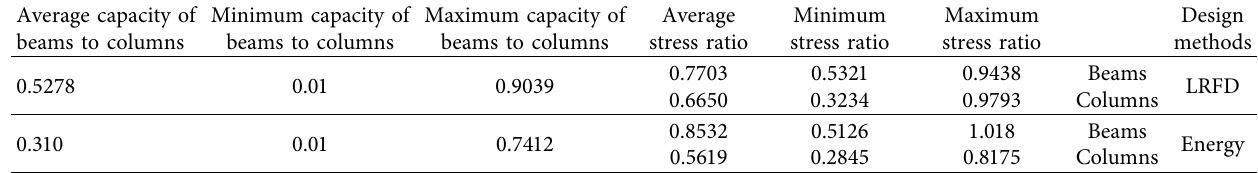
Table 7: Results of the analyses of LRDF, energy, and E-WOA methods in 16-story structures.